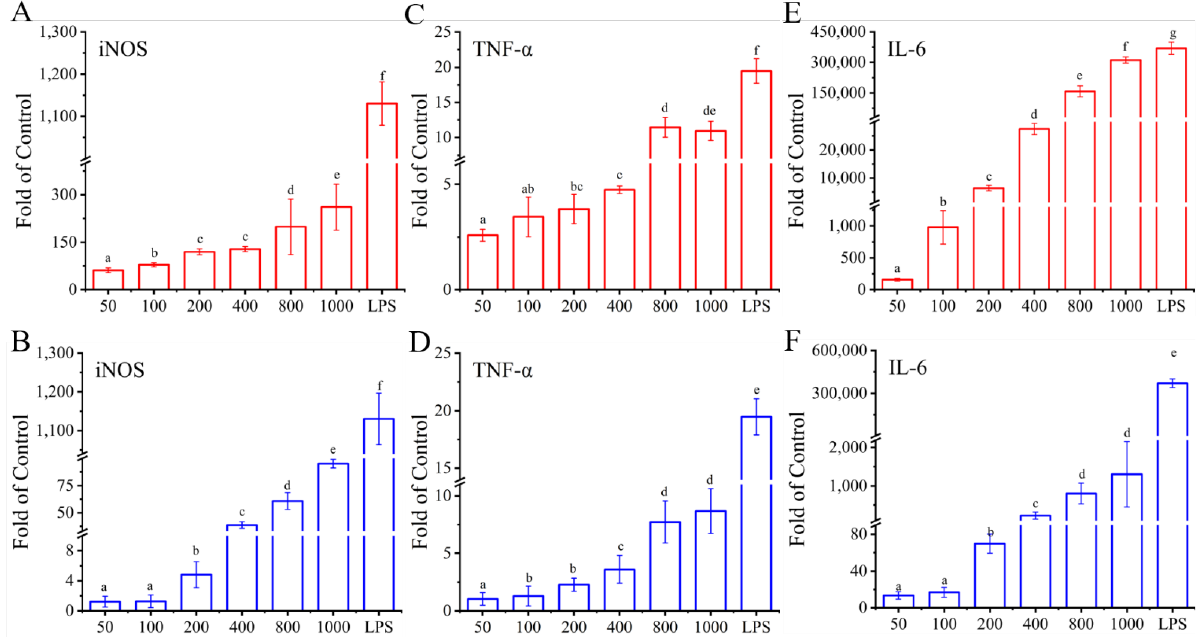
Figure 8. The effects of I01-2 and I01-4 on mRNA levels of iNOS ( A , B ), TNF- α ( C , D ), IL-6 ( E , F ) in RAW 264.7 cells, respectively. Different superscript letters (a – f) indicate significant differences ( p < 0.05) between the groups.